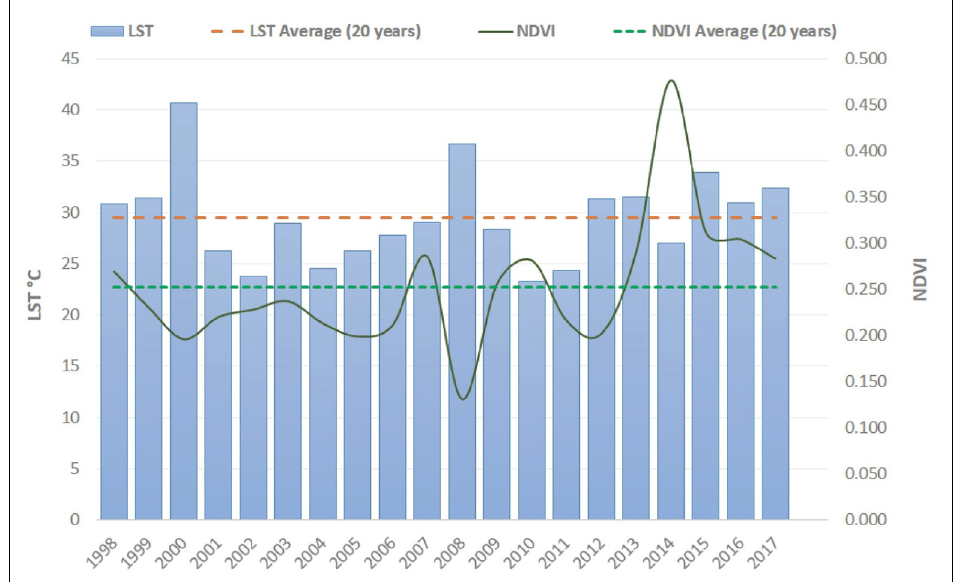
Figure 5. Average values of LST and NDVI in the study area (1998–2017).